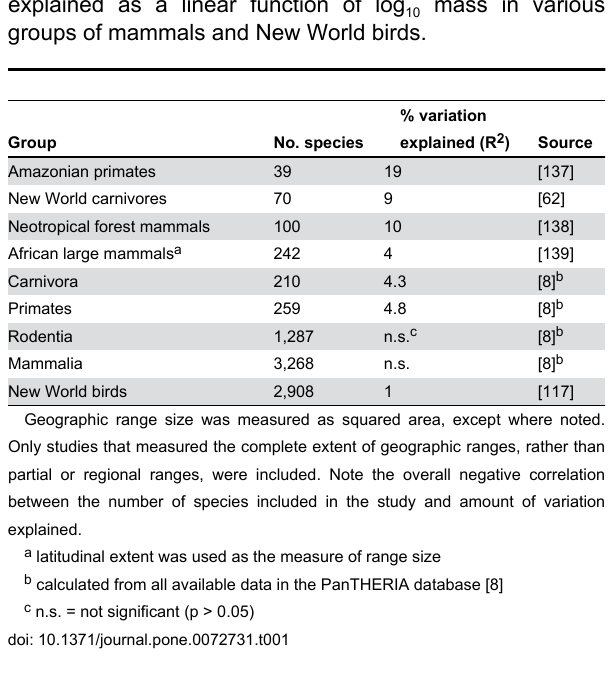
geographic range size 10 mass in various 10